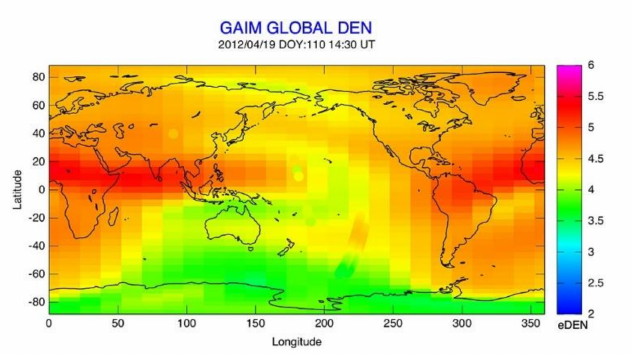
Figure 11. IED output at 800 km altitude, with the IED from radio occultation and defense mete- orological satellite program (DMSP) overlaid for comparison (from [85]). The DMSP data are in the southern hemisphere near 220 ◦ longitude, and the radio occultation density values are at 90 ◦ longitude and 40 ◦ latitude, and 180 ◦ longitude between 10 ◦ and − 10 ◦ latitude.